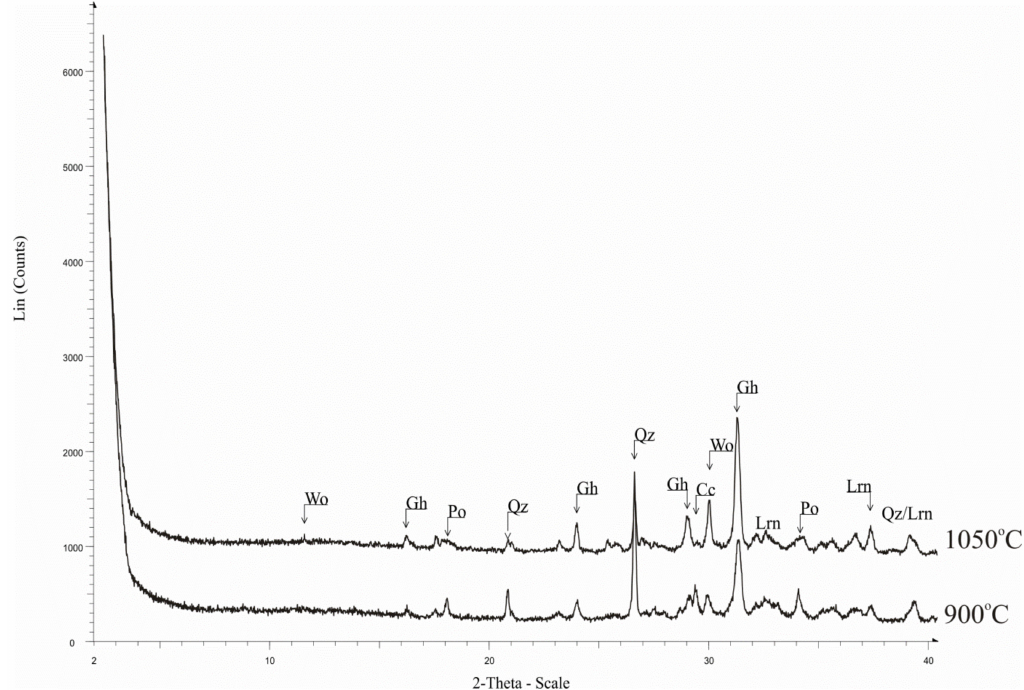
Figure 15. Composite graphs of the X-ray patterns from the fired calcareous material (700–1050 ◦ C). Abbreviations: Qz = quartz, Lrn = larnite, Po = portlandite, Gh = gehlenite, Wo = wollastonite, Cc =